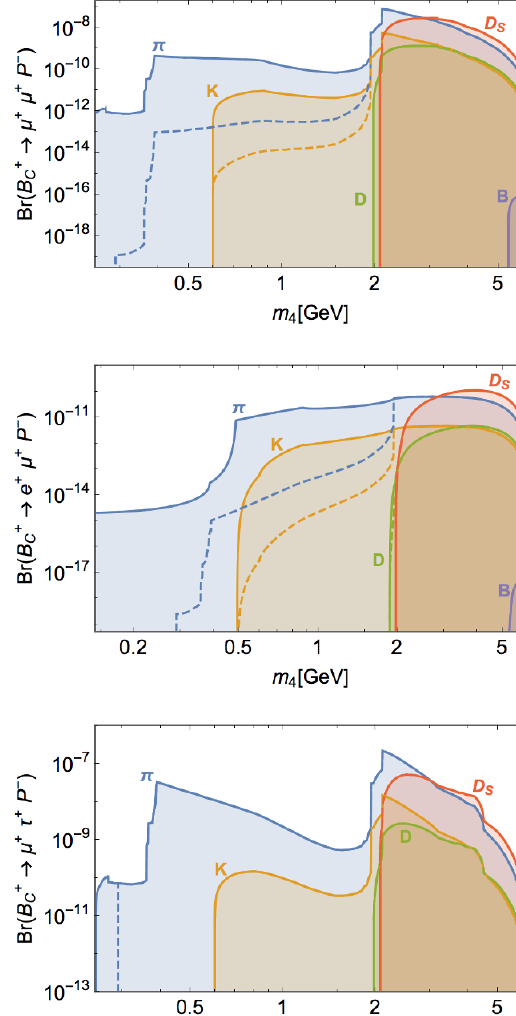
of (cid:12)gure 12 (we chose semileptonic B decays into a pseudoscalar meson (cid:12)nal state